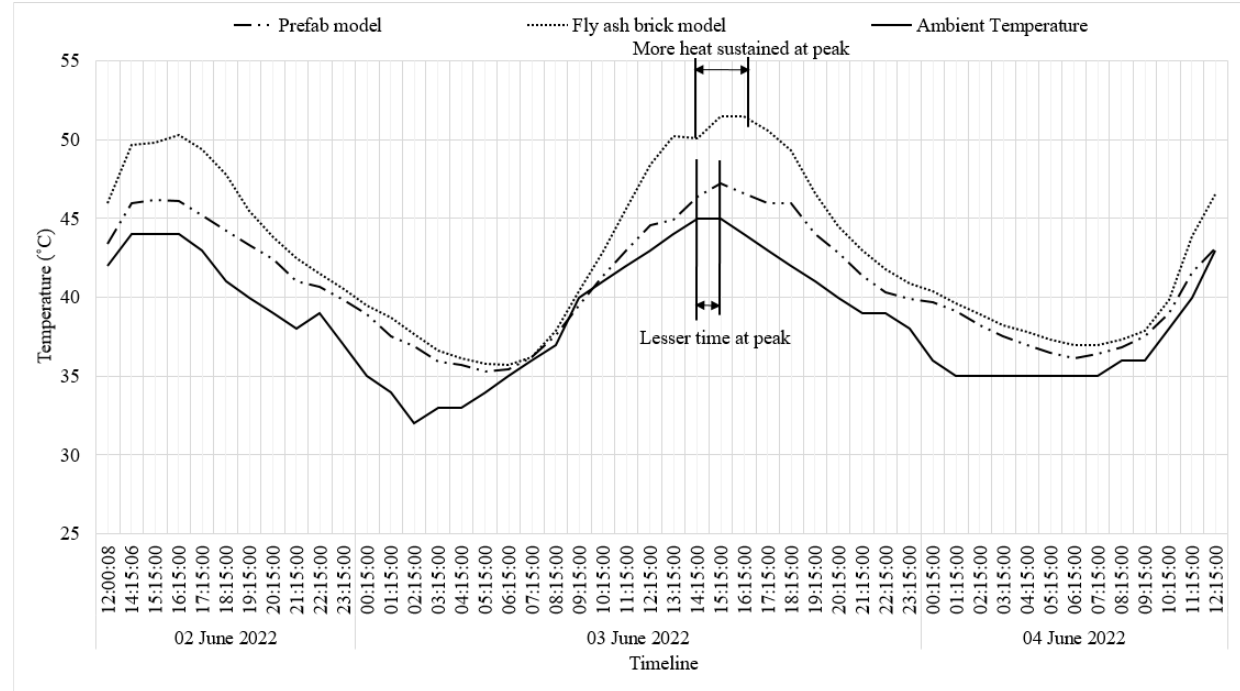
Figure 12. Comparison of maximum temperatures .